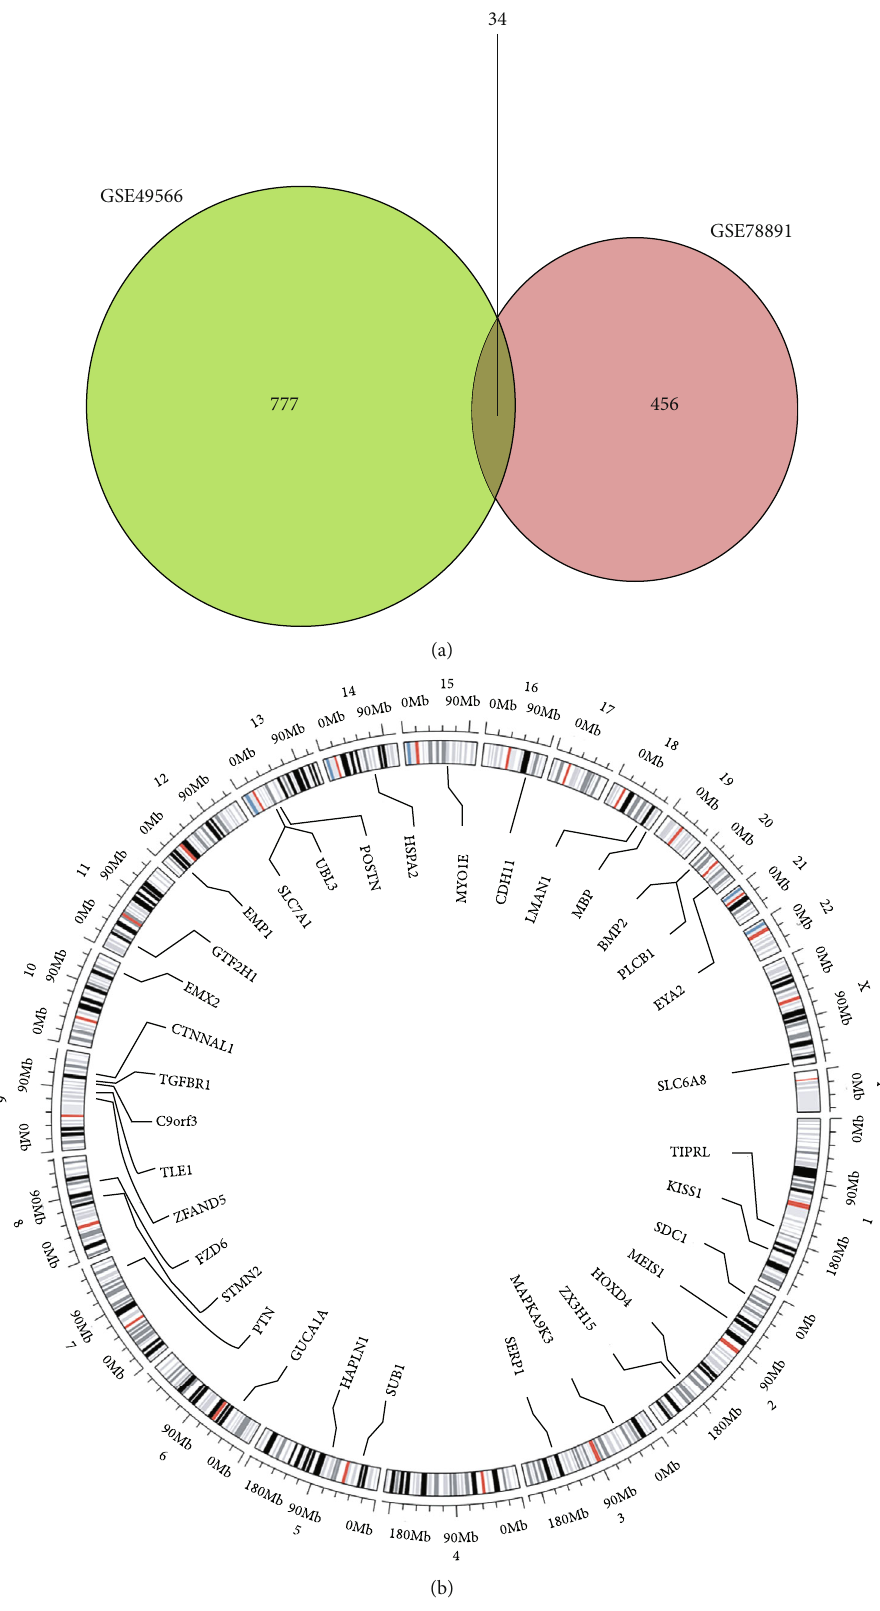
Figure 2: The information of common DEGs: (a) 34 common DEGs were identi fi ed between the two datasets; (b) the gene position information of the 34 common